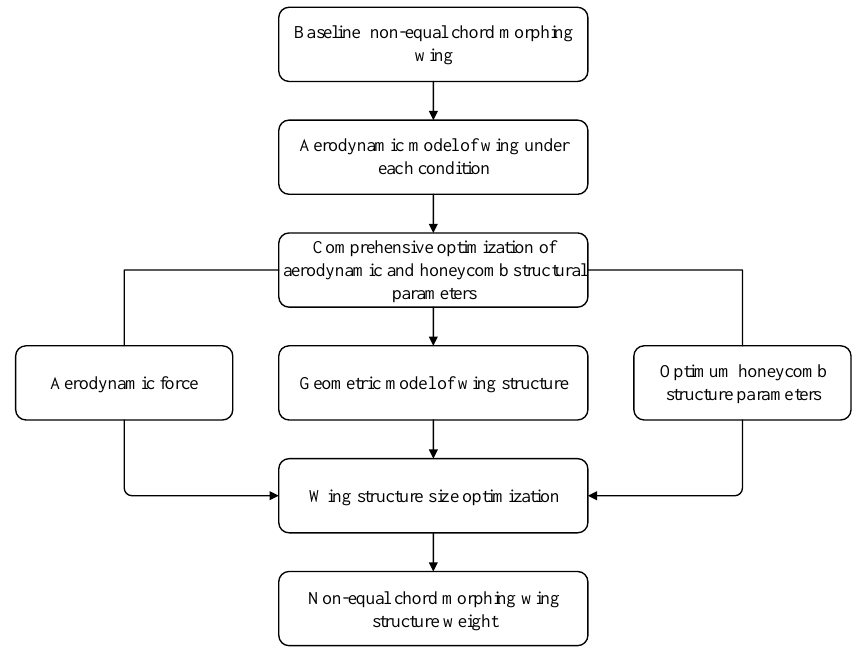
Figure 5. Multidisciplinary optimization flowchart of non-equal chord morphing wing.